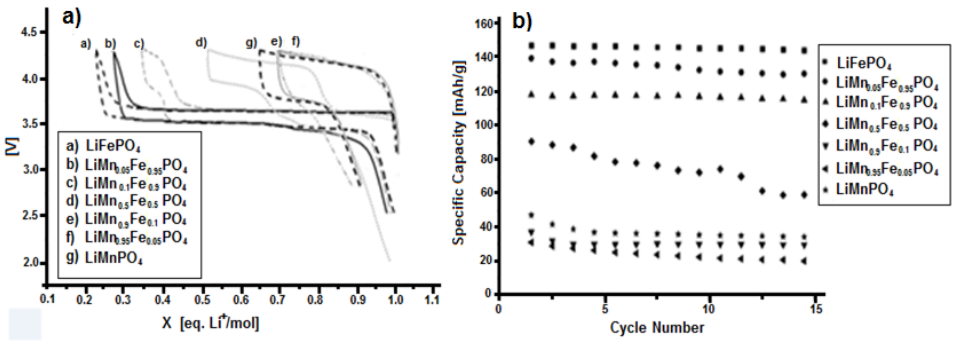
Figure 11. Results of tests at C/5 for LiMn x Fe (1 − x) PO 4 (x = 0.05; 0.1; 0.5; 0.9; 0.95): ( a ) Charge ‐ discharge curves; and ( b ) specific capacity.